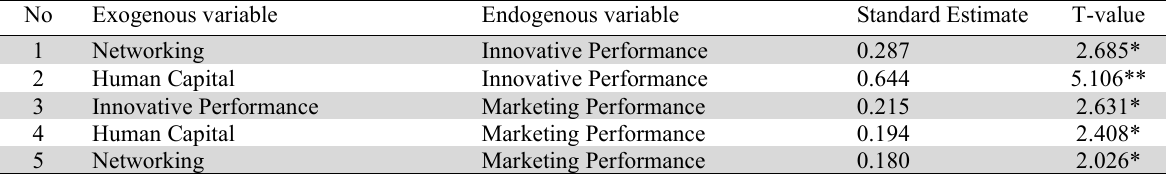
Inner Path Model Coefficients and their